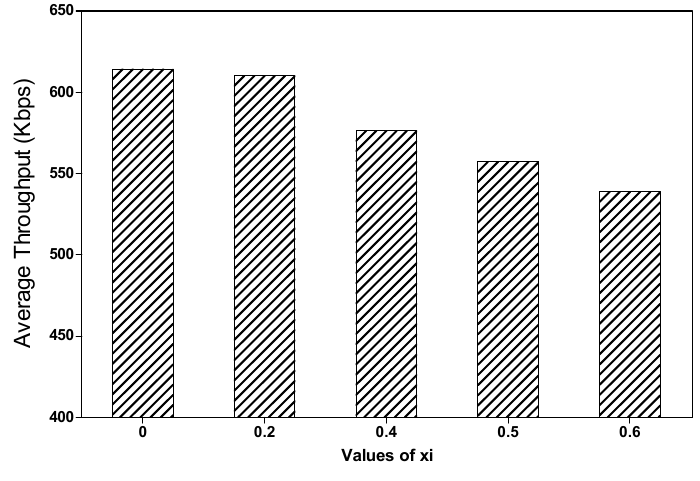
Figure 15. Effects of value of ξ on average throughput of